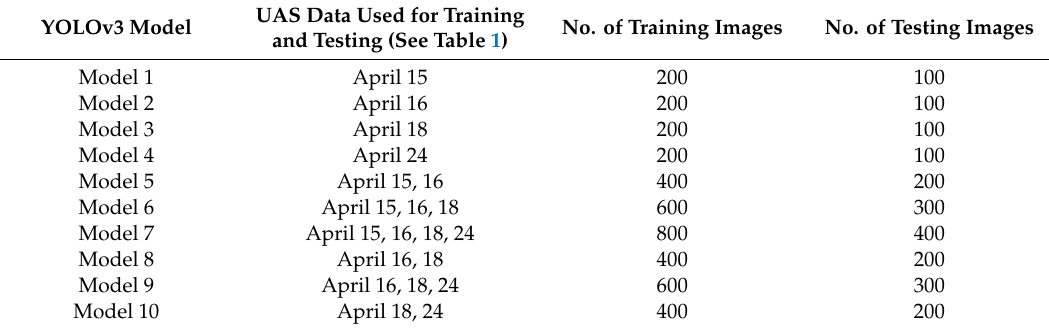
Table 2. YOLOv3 cotton detection models generated from di ff erent training and testing